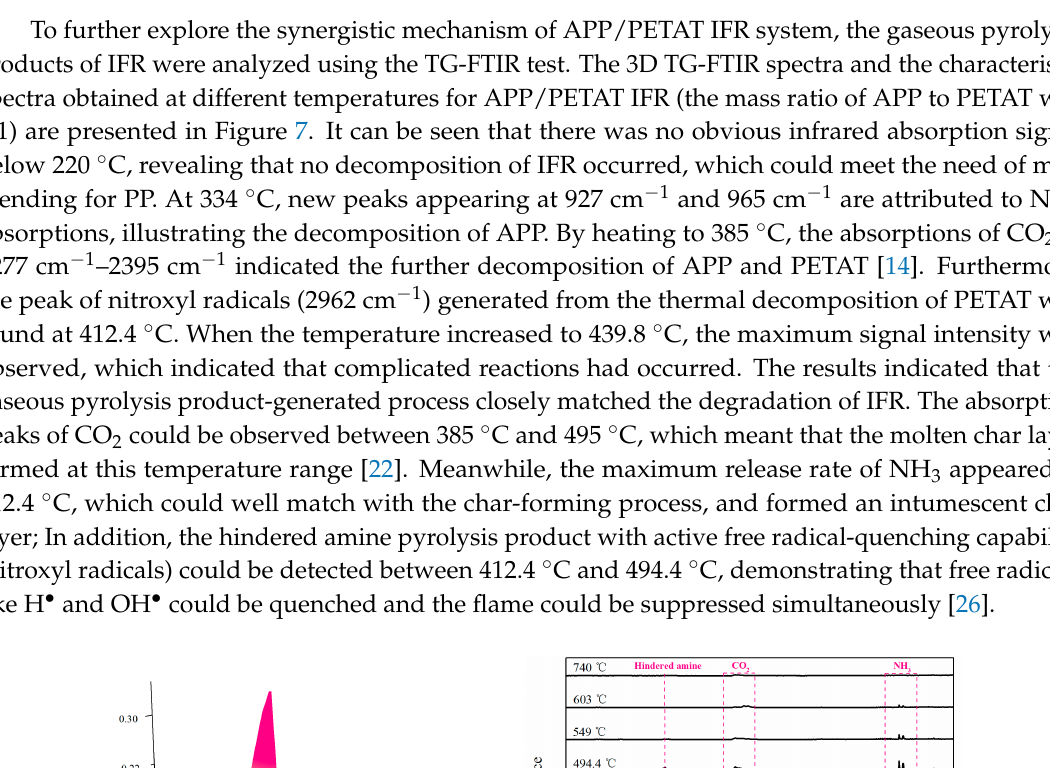
Figure 6. TGA ( a ) and DTG ( b ) curves of PP and PP composites under N 2.